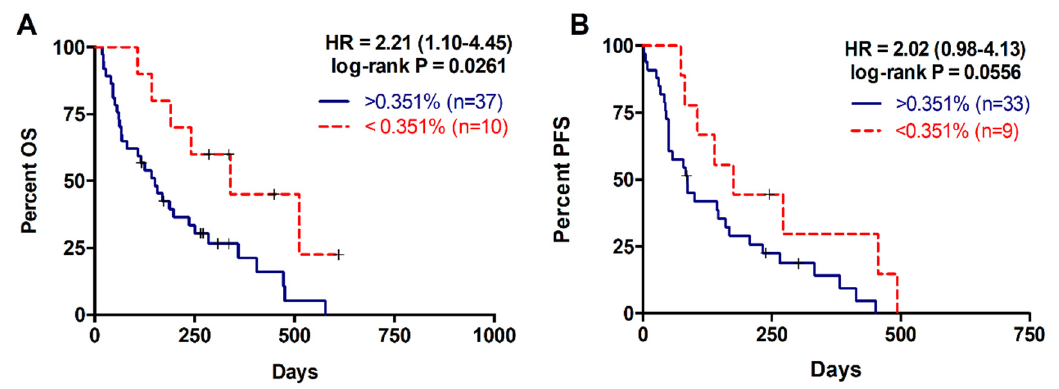
Figure 3. Overall and progression free survival rates according to circulating RAS mutation allele fraction (MAF). ( A ) OS according to circulating MAF (cut-off: 0.351%); ( B ) PFS according to circulating MAF (cut-off: 0.351%).